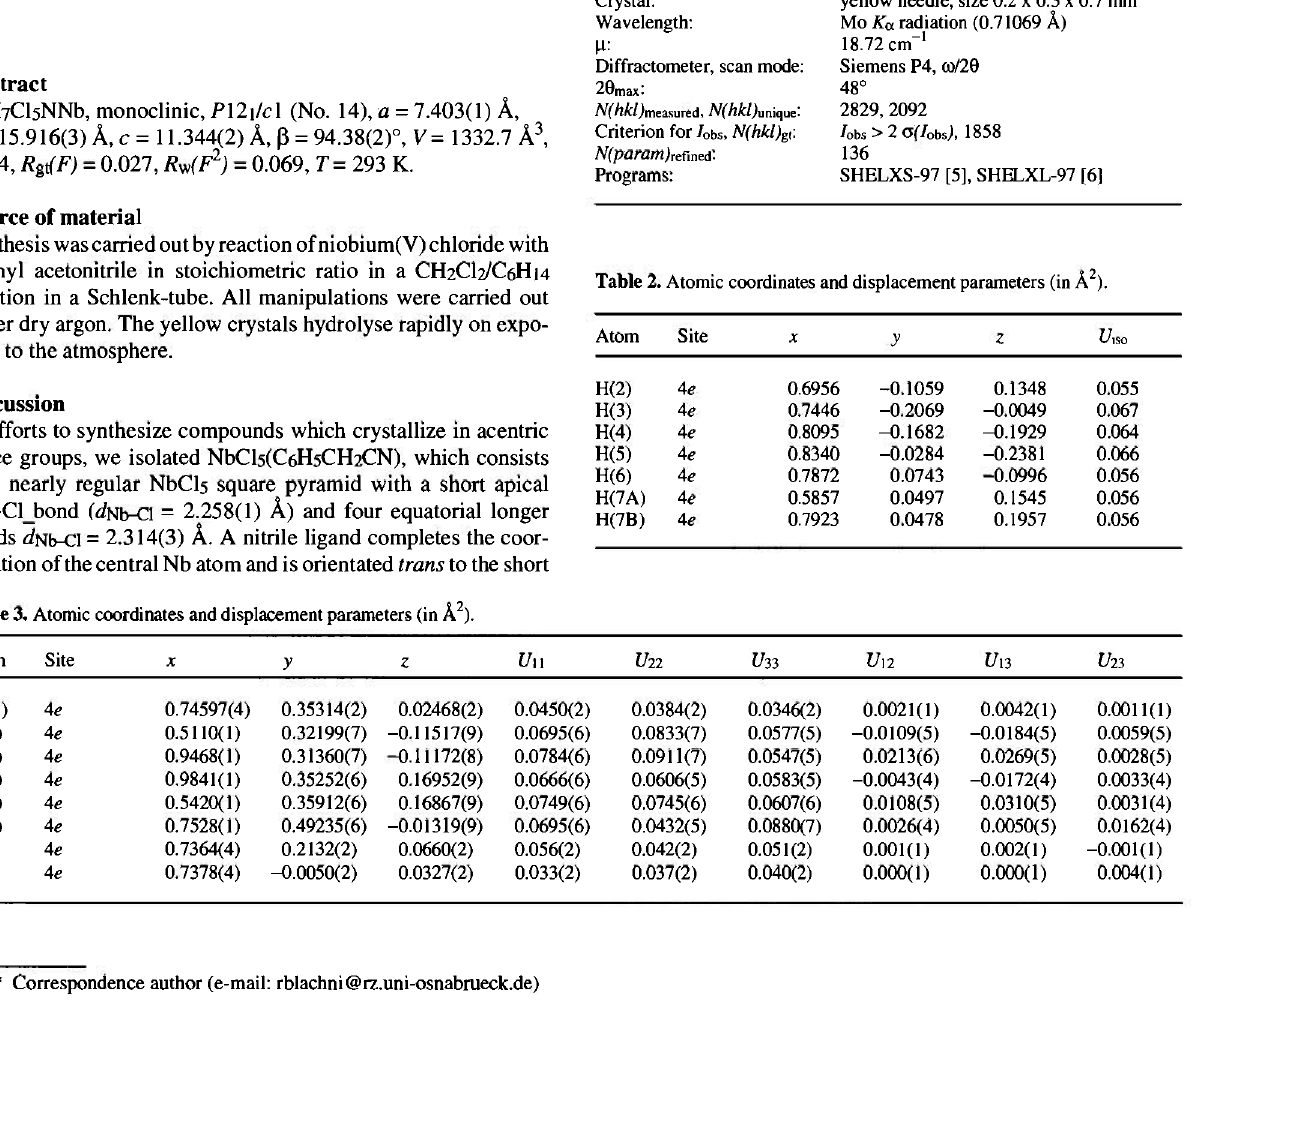
Table 1. Data collection and handling.